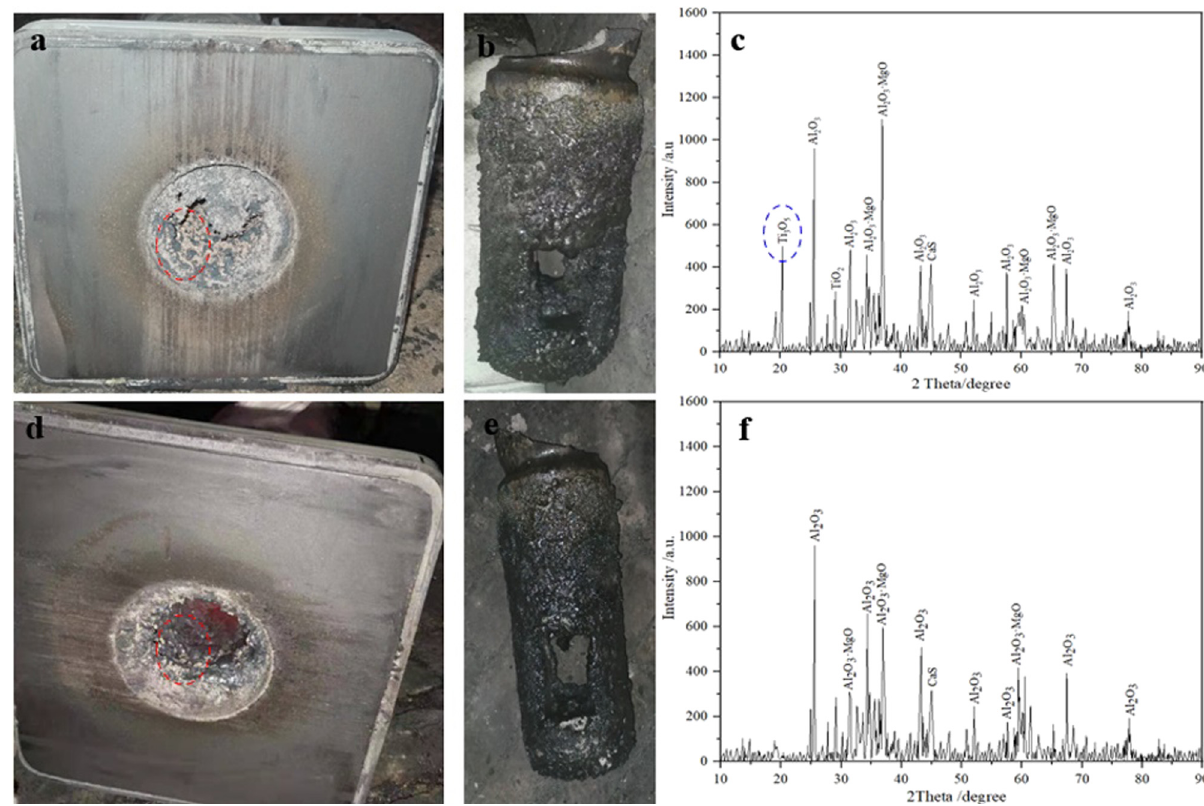
Figure 6: Comparison of nozzle conditions of two modi fi ers and the XRD patterns of the nodules. ( a ) Upper nozzle with the original modi fi er, ( b ) lower nozzle side hole with the original modi fi er, ( c ) XRD patterns of nodular at the nozzle with the original modi fi er, ( d ) upper nozzle with the new modi fi er, ( e ) lower nozzle side hole with the new modi fi er, and ( f ) XRD patterns of nodular at the nozzle with the new modi fi